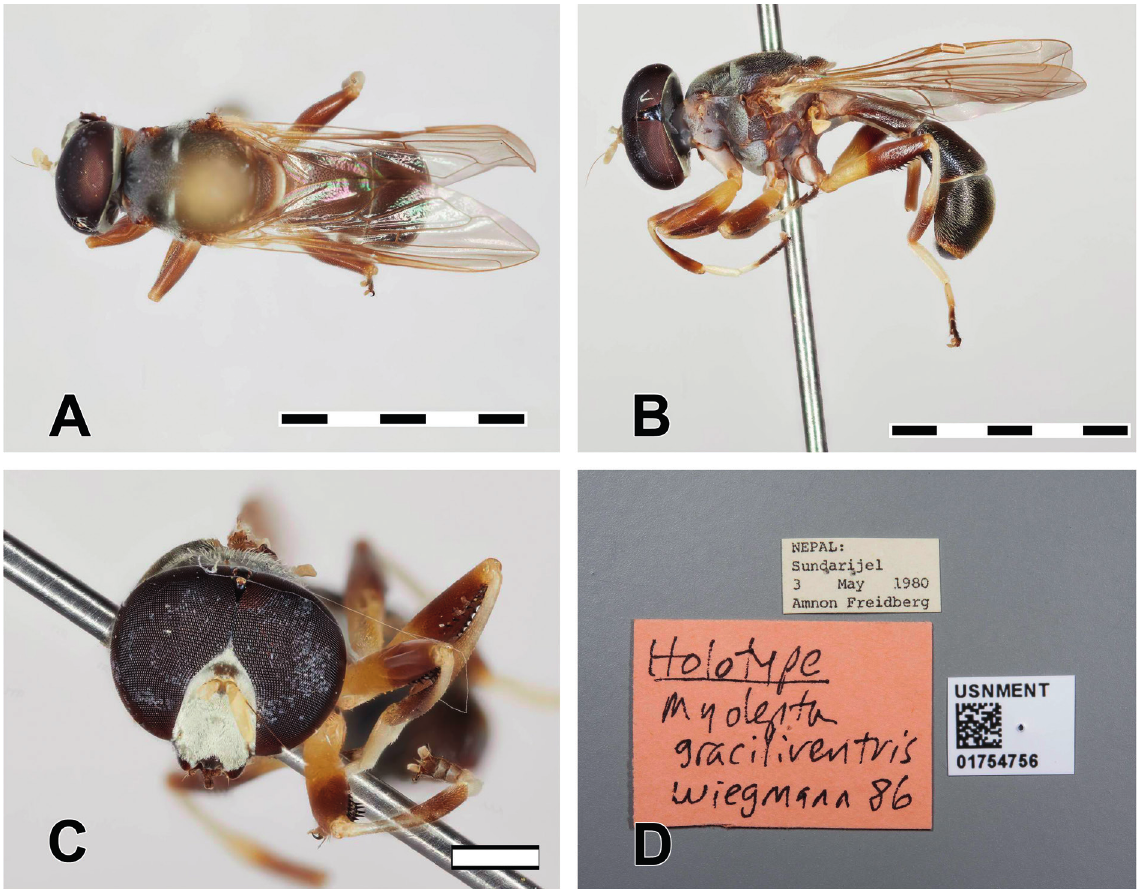
Fig. 2. Myolepta graciliventris Wiegmann, 1986, ♂, holotype (USNMENT01754756). A . Habitus, dorsal view. B. Habitus, lateral view. C . Head, frontal view. D . Labels. Scale bars: 1